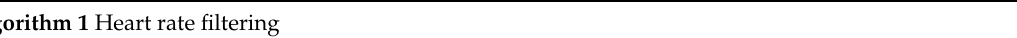
Algorithm 1 Heart rate filtering 1: Global Variables: